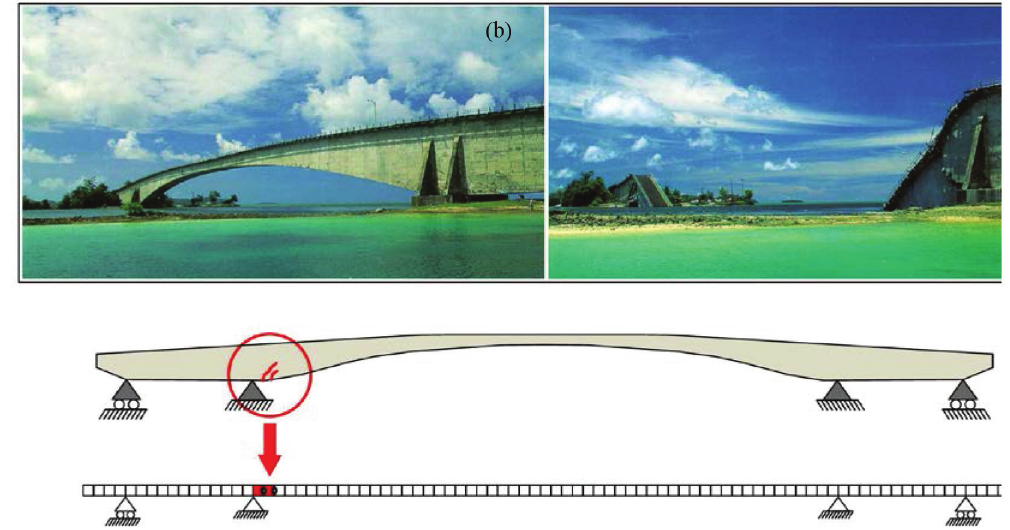
Fig. 4. Koror–Babelthuap bridge in Republic of Palau: (a) Actual structure (Courtesy of Bill Perryclear and Chris Burgoyne); (b) Collapsed structure (Courtesy of Bill Perryclear and Chris Burgoyne); (c) Detected Cracks (Burgoyne, Scantlebury 2006); and (d) Finite Element